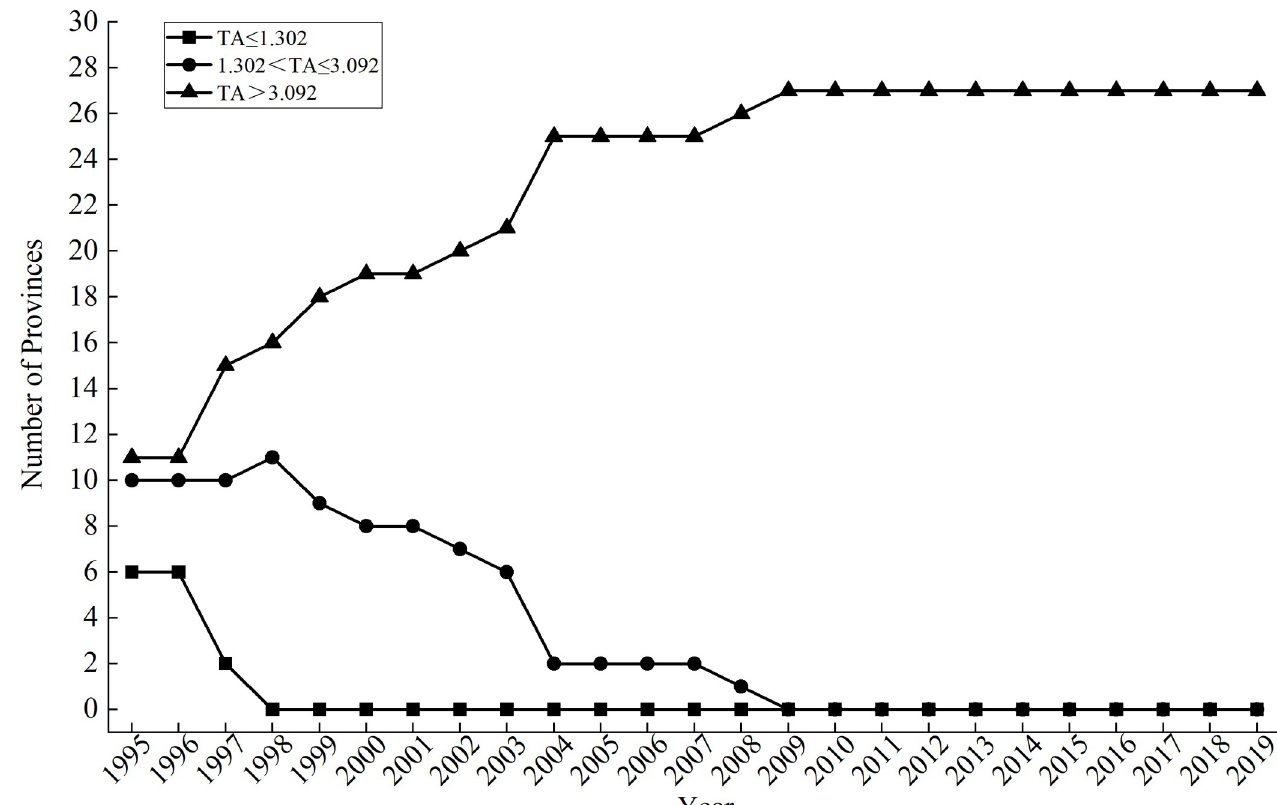
Fig 3. Time trend of the number of provinces in different technology accumulation